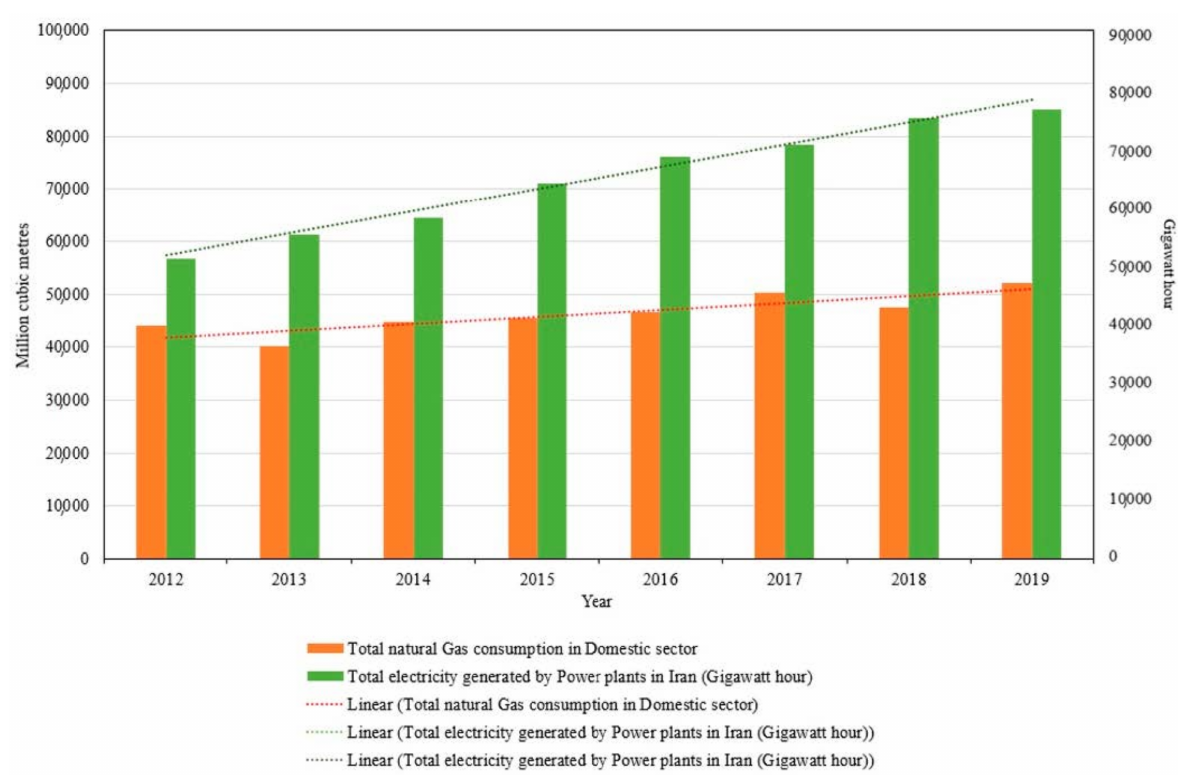
Figure 14. The rise in end-use electricity and end-use natural gas consumption of occupants in the domestic sector in Iran from 2012 to 2019.